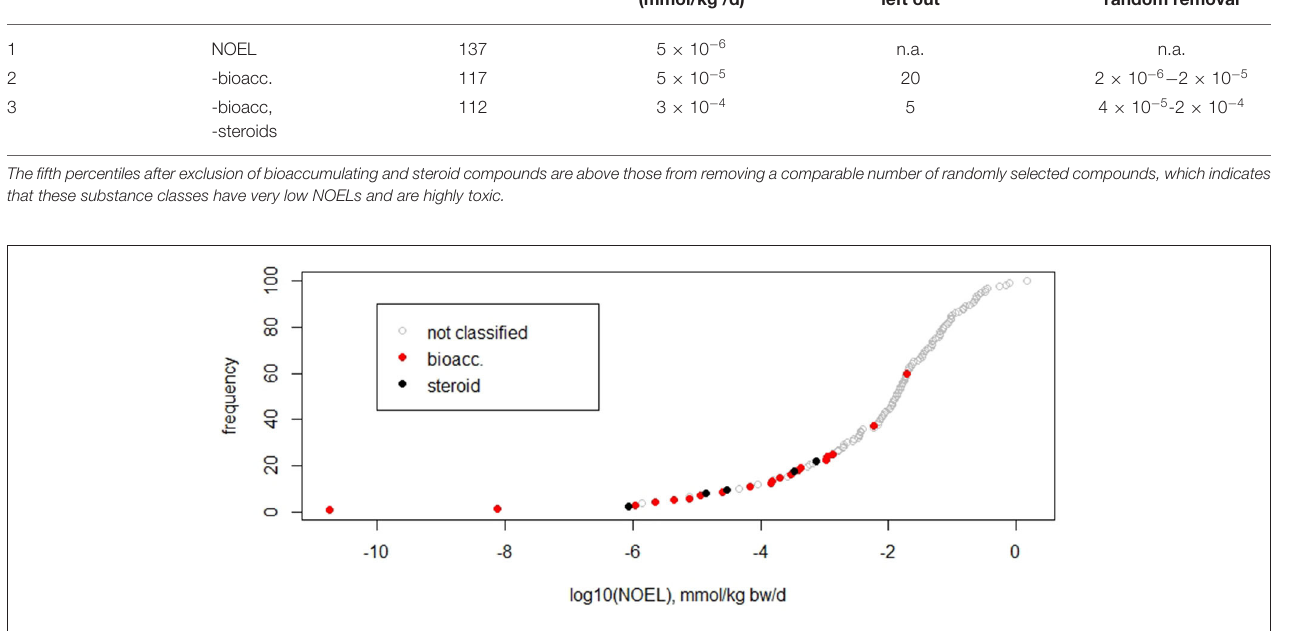
FIGURE 2 | Cumulative frequency plot of NOEL values indicating subgroups of compounds, such as bioaccumulating in humans (bioacc) and steroids.